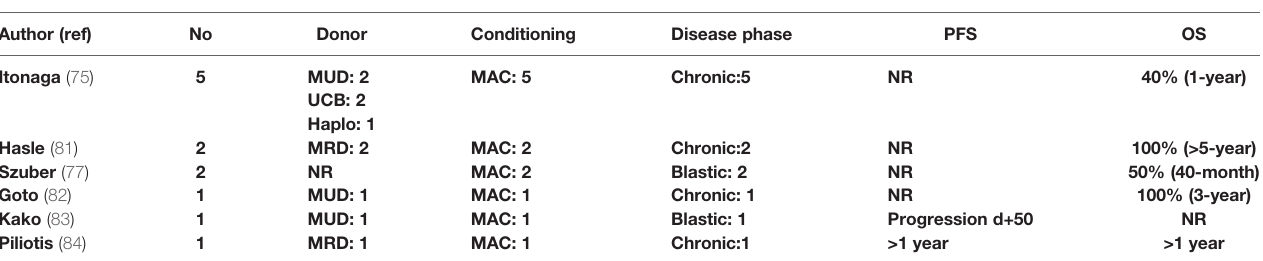
TABLE 4 | Allogeneic stem cell transplantation in patients with